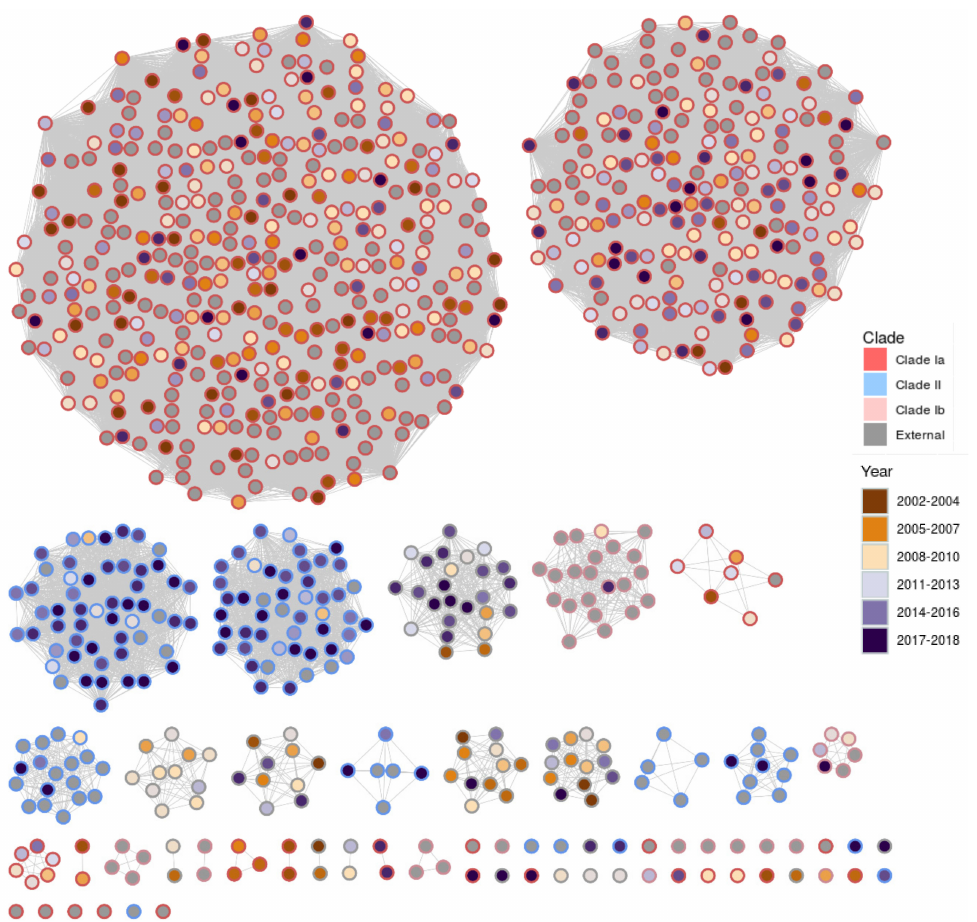
Figure 1. Clusters generated by PopPUNK including Public Health England (PHE) genomes and data from Azarian et al. [7]. Nodes are coloured by the year in which the sample was received by PHE. Azarian et al. [7] data points are filled in grey. The outer circle shows the clade number (grey indicates no clade was